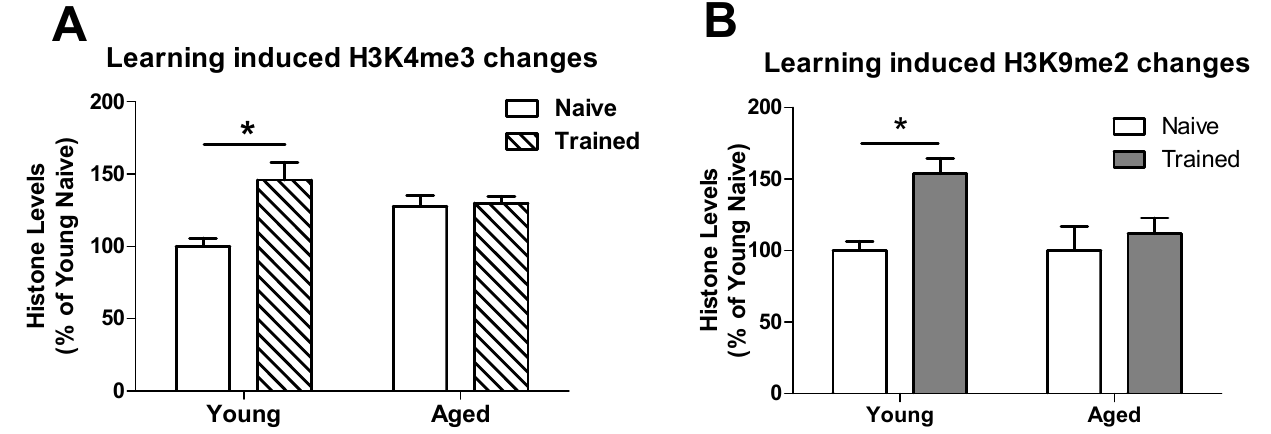
Figure 2. Learning-induced histone H3 methylation levels are altered in the aged hippocampus. Young and aged adults were sacrificed from their home cages (naïve) or at 1 h after training in NOR paradigm (Trained). Histone modification levels were detected by Western blotting and quantified by optical densitometry. H3K4me3 and H3K9me2 levels were assessed in area CA1 of the hippocampus. ( A ) Significant increases in H3K4me3 were detected in young-trained adults relative to young-naïve adults. A significant interaction between aging and learning (training) was detected, and learning-dependent increases in H3K9me2 levels seen in young adults were disrupted in aged adults; ( B ) Significant increases in H3K9me2 levels were detected in young-trained adults relative to young-naïve adults. No significant interaction was detected between aging and training; however, learning (training) induced increases in H3K9me2 observed in young animals were disrupted in aged animals. Results are presented as a percentage of young adult naïve. Group sizes: young naïve, n = 3; young trained, n = 5; Aged naïve, n = 4, Aged trained, n = 6. Two-Way ANOVA ; * p < 0.05. Data are shown ±